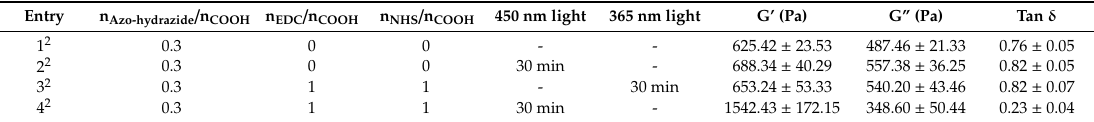
Table 1. The mechanical properties of the pre-gel with and without EDC, NHS and 450 nm light